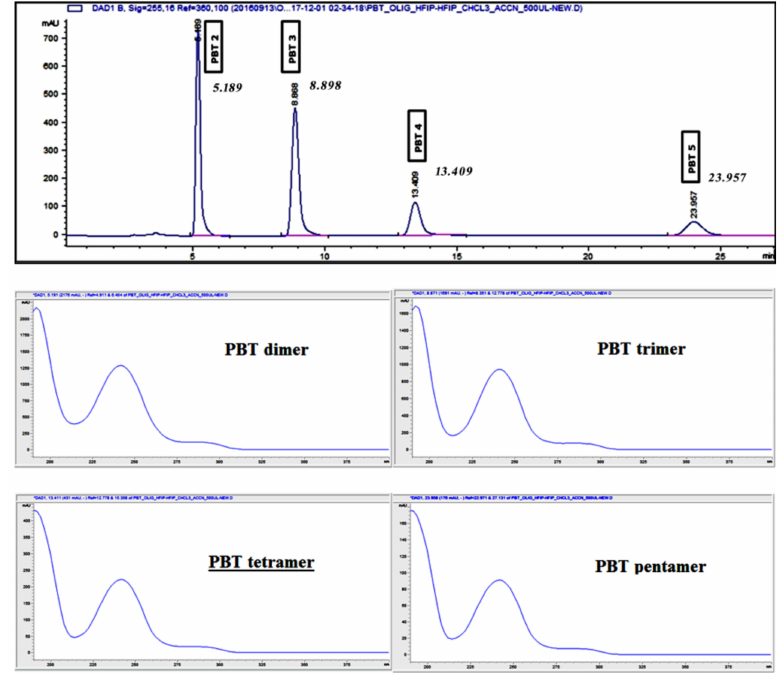
Figure 2. p-HPLC-DAD chromatogram of the raw polymeric material. Ultraviolet (UV) spectra for each oligomer are also presented ( λ = 200–400